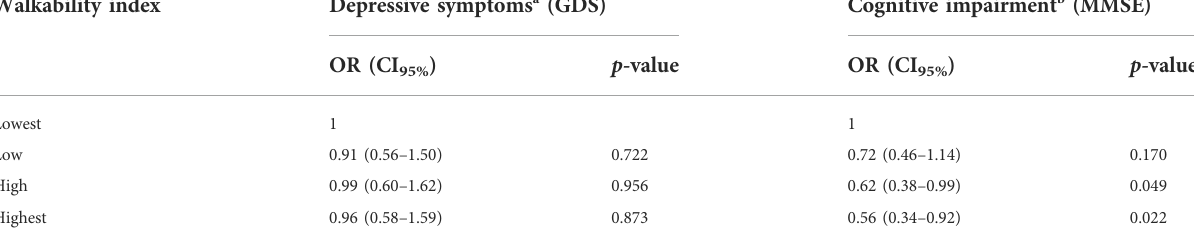
TABLE3 AdjustedassociationbetweenneighborhoodwalkabilityandmentalhealthinolderadultsfromFlorianopolis, Brazil. EpiFloripa AgingStudy, 2017 – 2019 (n = 1,162). Walkability index